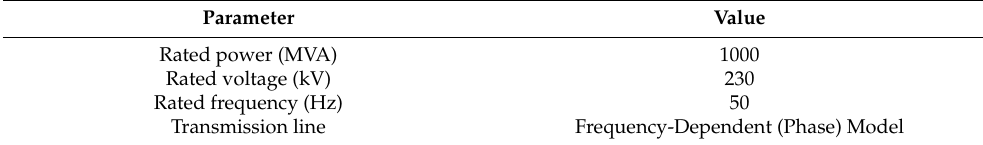
Table 3. AC grid